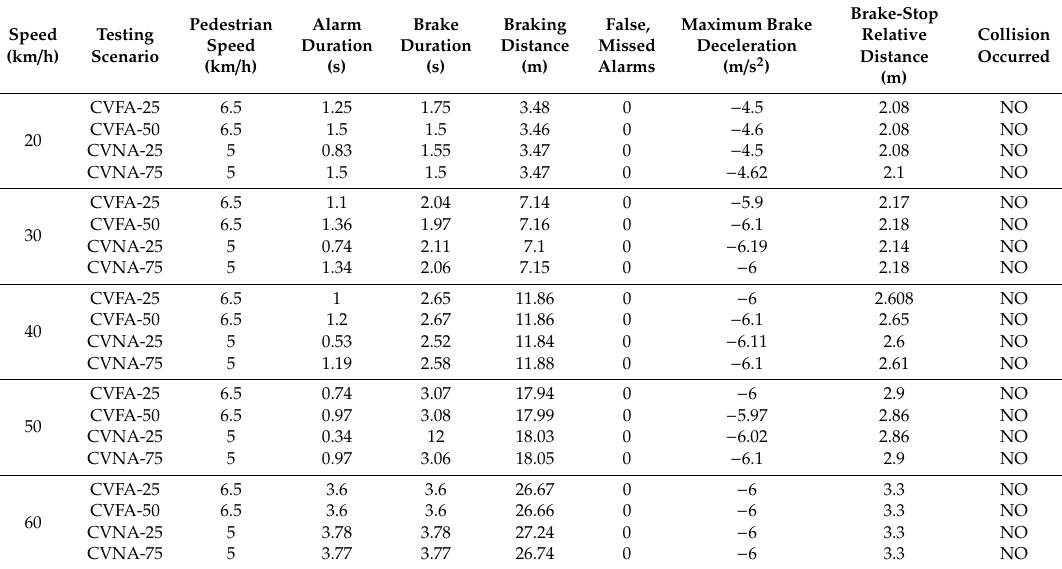
Figure 29. The simulation time as a function of station ( a ), velocity ( b ), warning signal ( c ), deceleration of the vehicle ( d ) in CVNA-75 scenario at the vehicle speed of 50 km / h. The test simulation results of the CVFA-25, CVFA-50, CVNA-25, and CVNA-75 scenarios are summarized in Table 14. Table 14. Simulation results under the AEB-P test